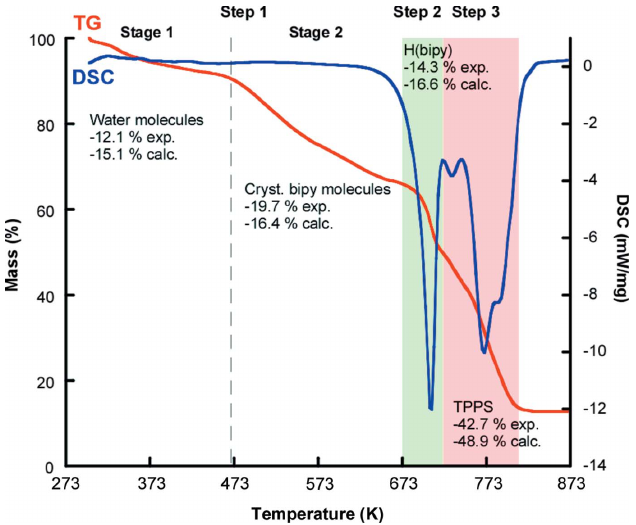
Figure 5 Thermal analysis for compound 1